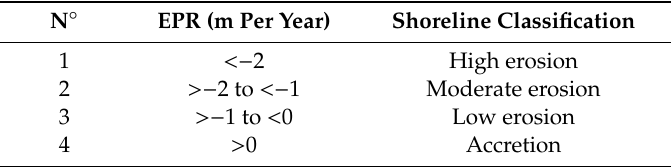
Figure 3. Examples of Digital Shoreline Analysis System (DSAS) transects and baseline map used for the analysis of the shoreline change along the study area: ( a ) B.C.S.; ( b ) B.C.; ( c ) Sonora; ( d ) Sinaloa. Table 2. Shoreline classification based on End Point Rate